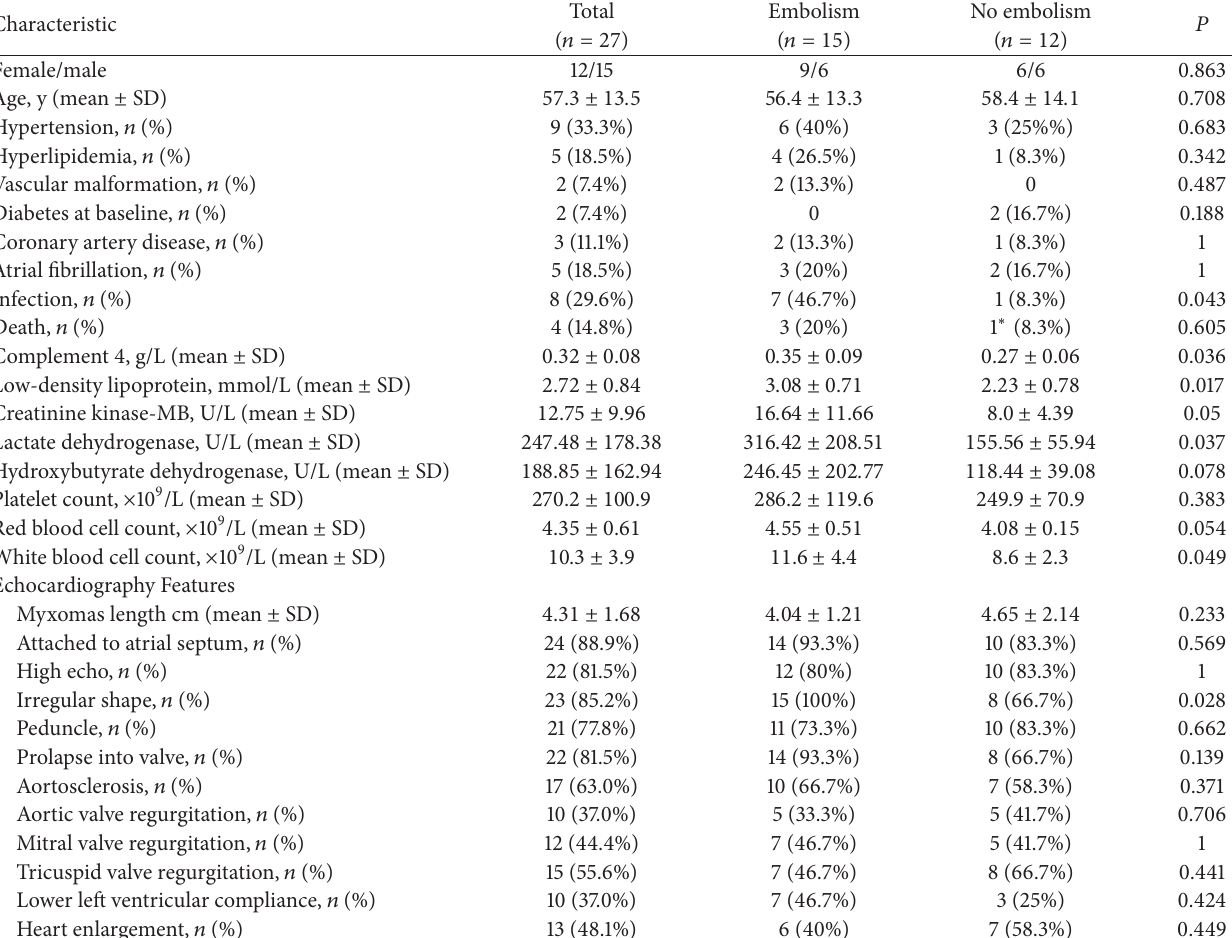
Table 1: Clinical features of patients with cardiac myxoma with brain